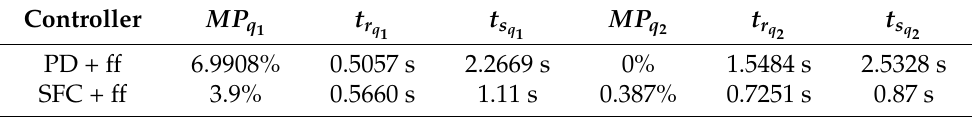
Table 4. Transient response comparative of the simulation results without F C .